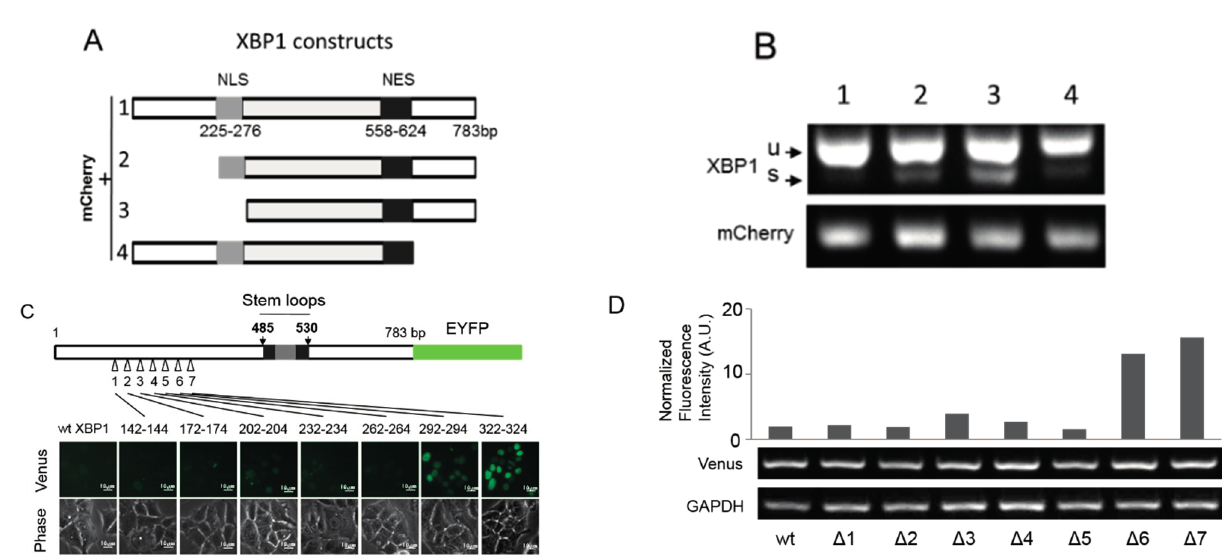
Figure 3. Effects of flank sequences of stem-loop pair on the splicing of XBP1 mRNA. ( A ) Constructs of mCherry followed by XBP1 fragments. The number indicates the position of nucleotides in unspliced XBP1. NLS, putative nuclear localization sequence; NES, putative ( A ) was subjected to RT-PCT with XBP1 primers and mCherry primers; ( C ) Effect of 5 ′ -nucleotide sequence of XBP1 mRNA on its basal splicing (scale bar = 10µm).